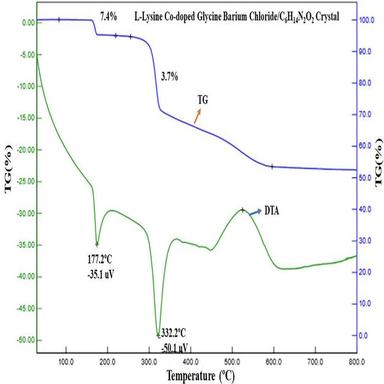
TG and DTA curve of pure and Co-doping L-LGBCAC.